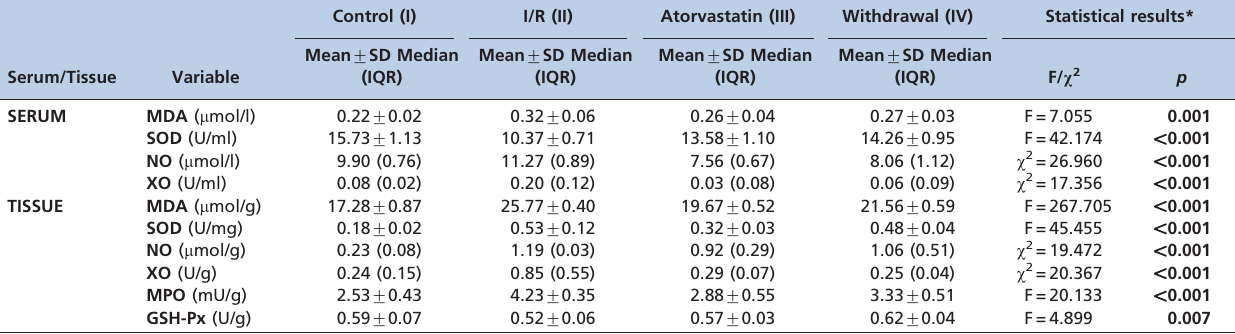
Table 1 - The levels and activities of various biochemical markers in the sera and spinal cord tissues of the experimental groups.